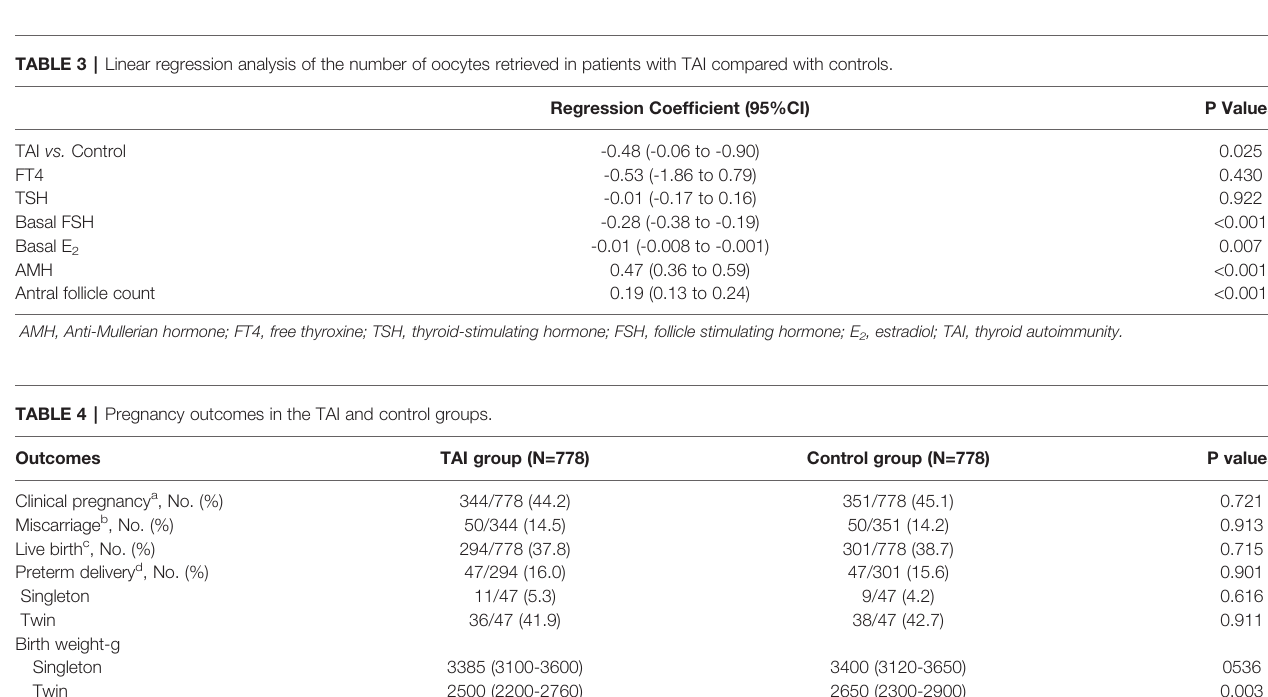
TABLE 3 | Linear regression analysis of the number of oocytes retrieved in patients with TAI compared with controls.